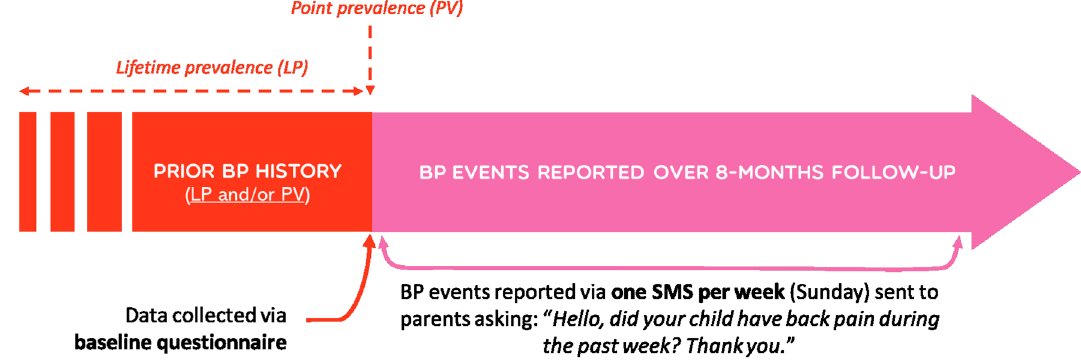
Figure 1. Prior BP history and BP events reporting.